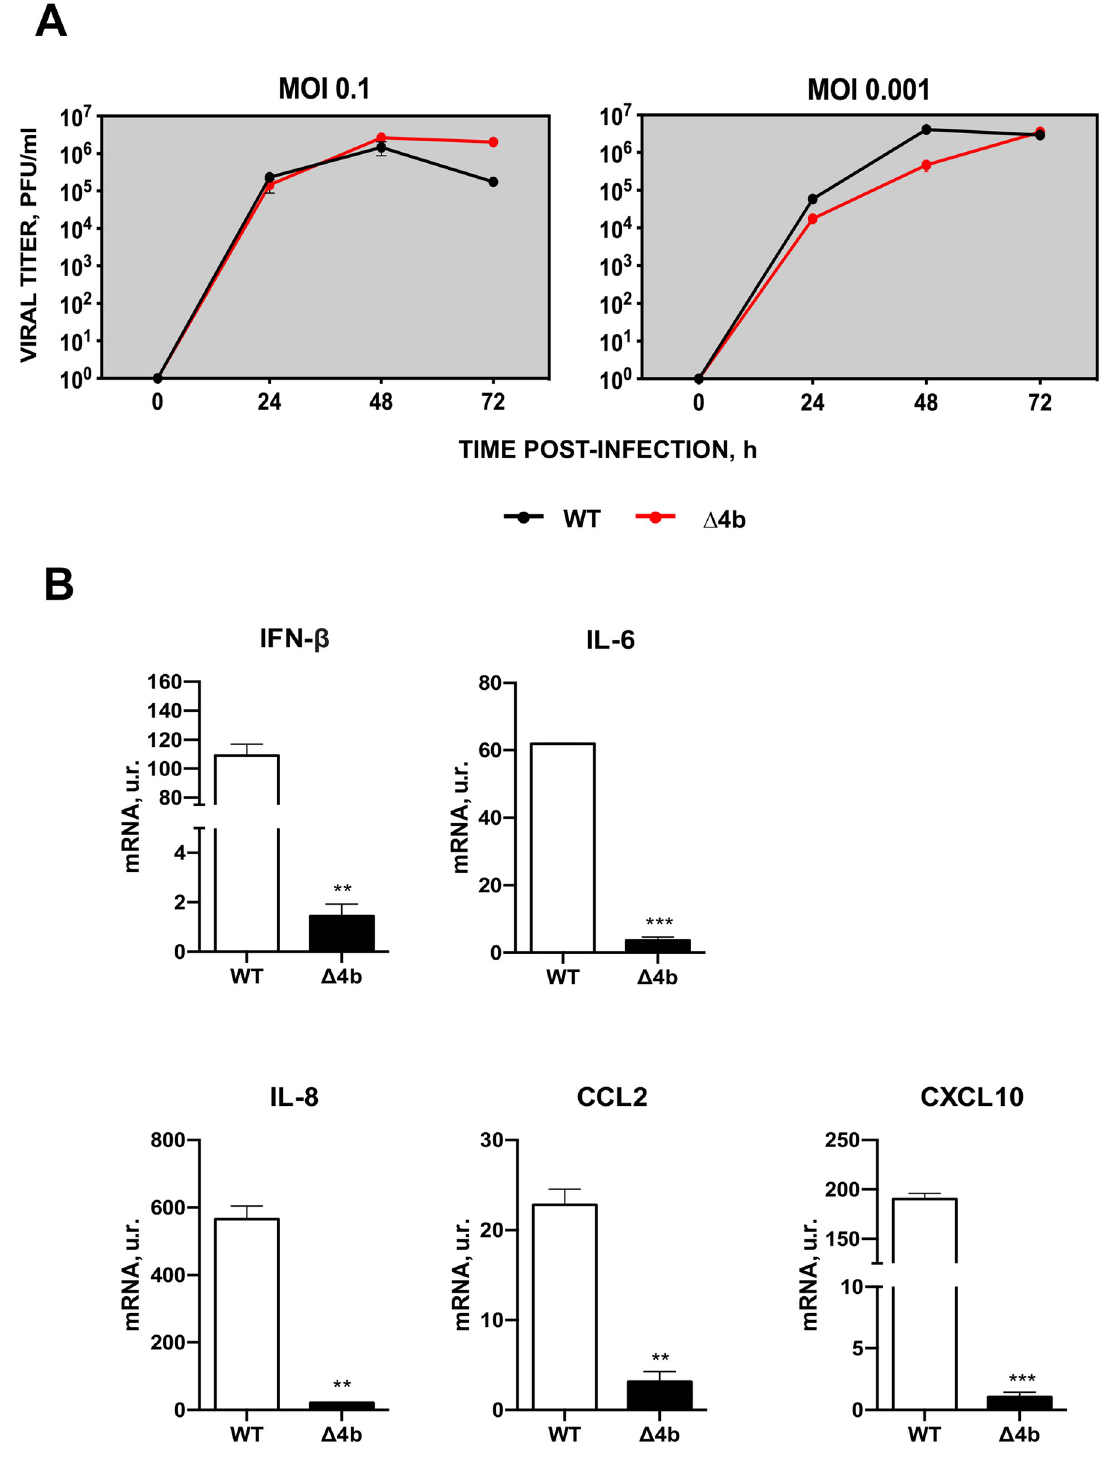
Fig 4. Characterization of MERS-CoV-MA-WT and MERS-CoV-MA- Δ 4b in MRC-5 cells. (A) Subconfluent monolayers of MRC-5 were infected with wild-type or Δ 4b at a m.o.i. of 0.1 or 0.001. Culture supernatants were collected at 24, 48 and 72 h p.i. and titrated by plaque assay. The average of two independent experiments is represented. (B) The mRNA expression levels of genes related to the IFN or the pro-inflammatory responses were quantified by RT-qPCR in MRC-5 cells either mock-infected or infected with WT or Δ 4b viruses at m.o.i. 1 and 24 h p.i. Error bars represent standard deviations of the mean (n = 3). Differences were analyzed by Student’s t test: � , p- value < 0.05; �� , p-value < 0.01. https://doi.org/10.1371/journal.ppat.1010834.g004 PLOS Pathogens| https://doi.org/10.1371/journal.ppat.1010834 September 21,